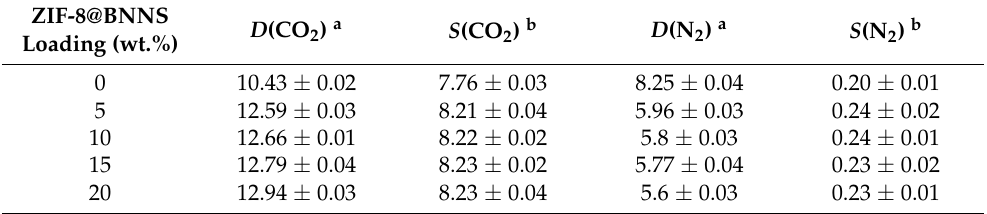
Table 3. Gas diffusivity coefficients and solubility coefficients of ZIF-8@BNNS/Pebax